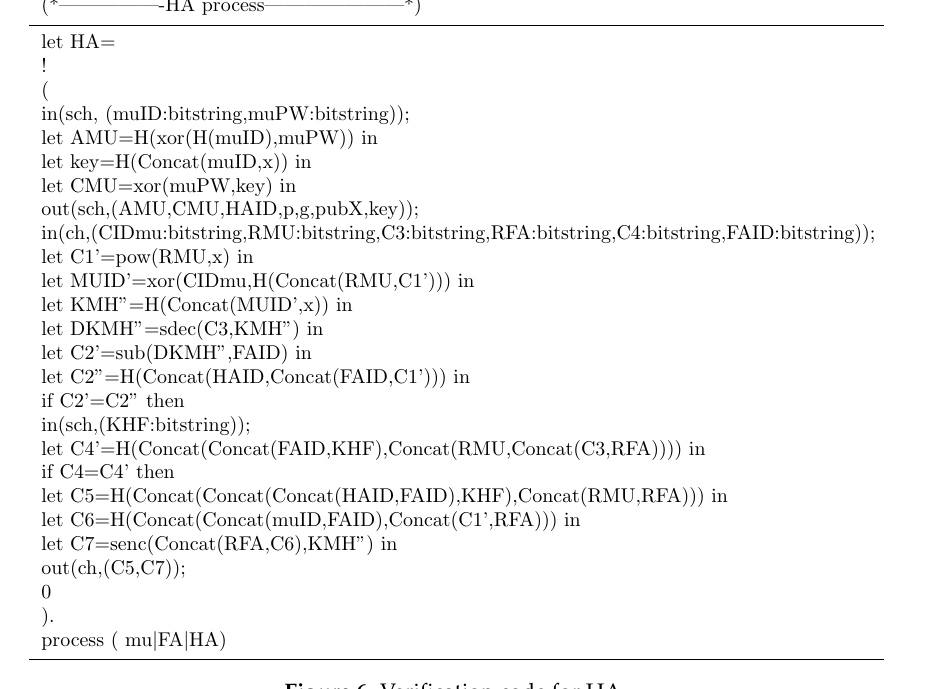
Figure 6. Verification code for HA.